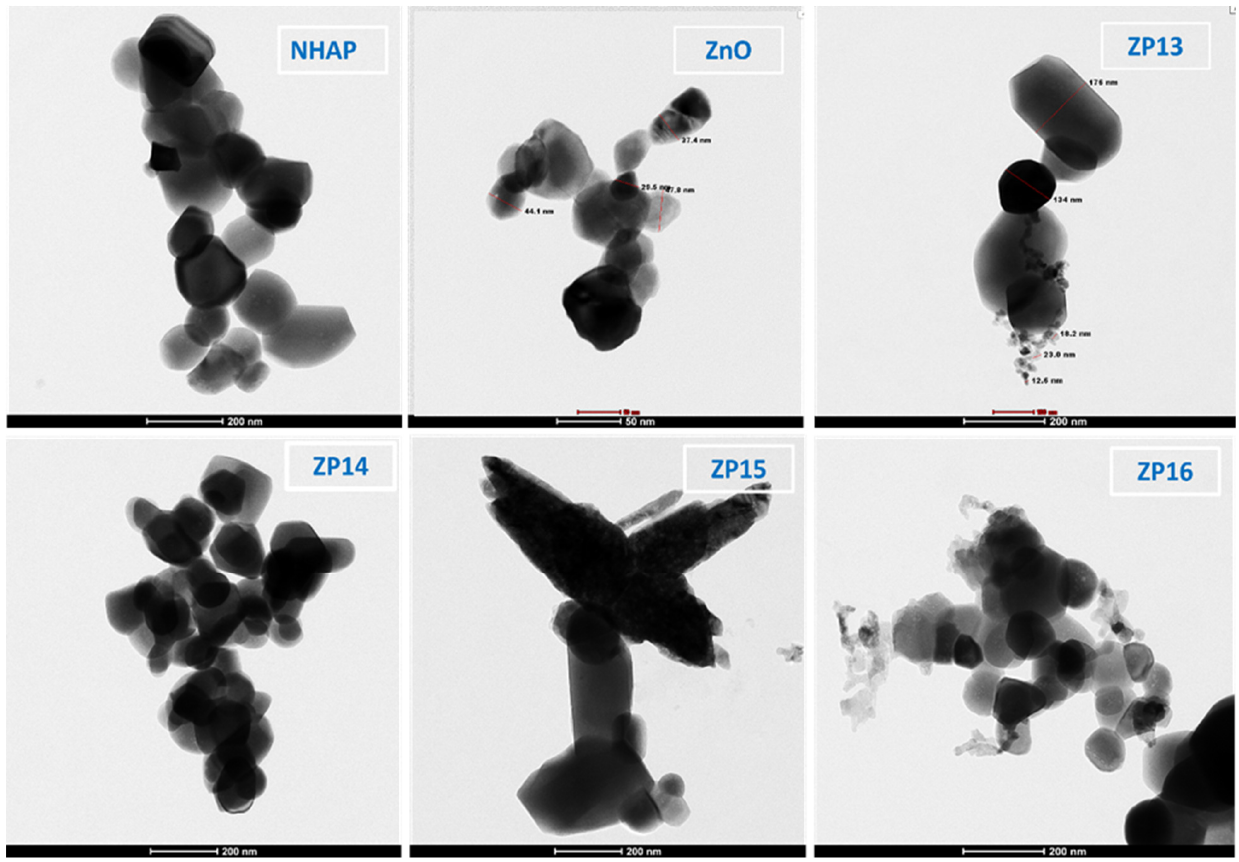
Figure 4. TEM images of NHAP, ZnO, and different ZnO/NAHP composite samples.